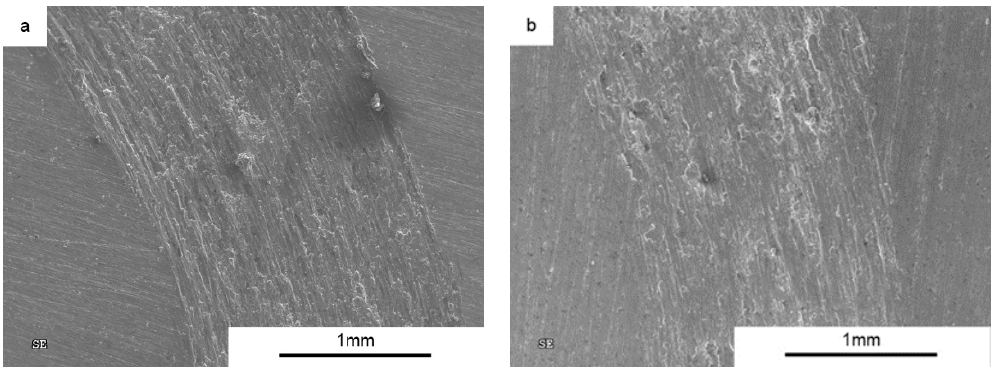
Figure 14. Worn Surface morphology for AA6061 + 2 vol % MLG load 1N ( a ) SPS and ( b ) SPT.